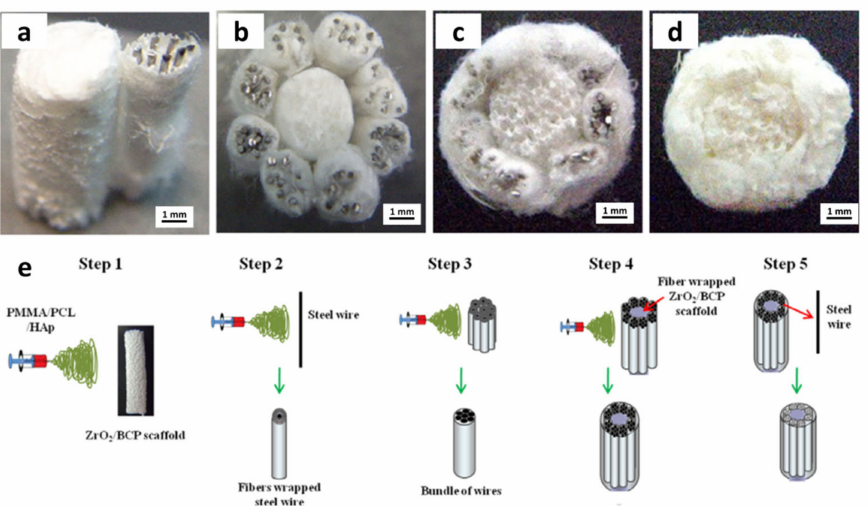
Figure 14. Photographs ( a – d ) and schematic ( e ) of the production of artificial bone. ( a ) A bundle of wires attached to the zirconia/BCPscaffold; ( b ) zirconia/BCP scaffold surrounded by bundles; ( c ) bundles surrounded by PCL/PMMA/HA; ( d ) after the steel wires were removed. Reprinted with permission from Lee et al. [105] , copyright©